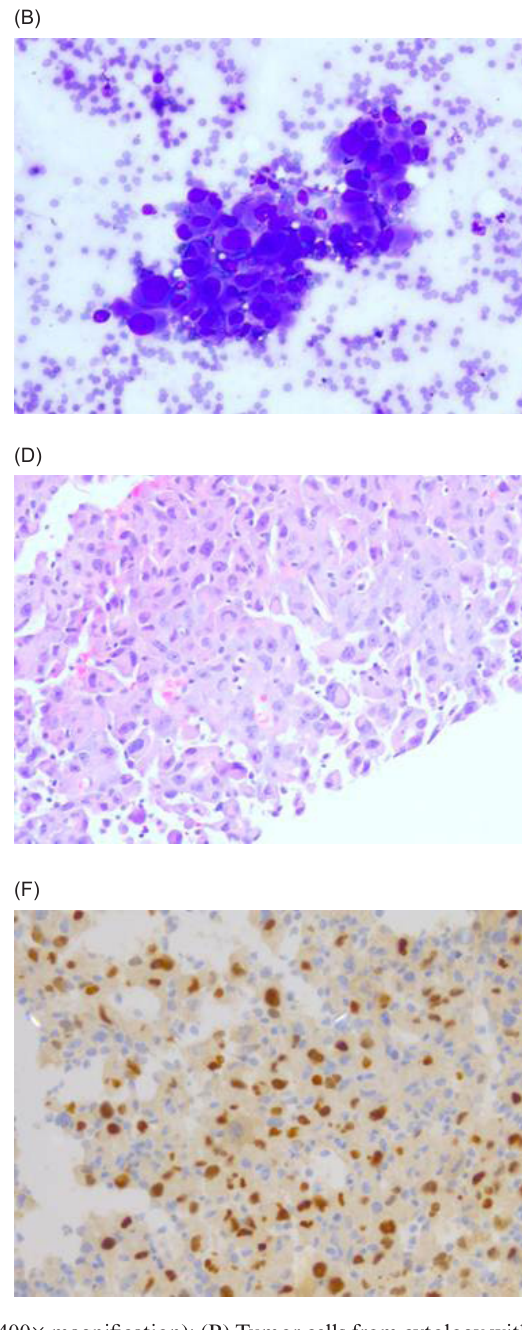
Figure 4: (A) Tumor cells from cytology with Papanicolaou stain (400× magnification); (B) Tumor cells from cytology with quick diff stain (400× magnification); (C–D) Tumor with featured rhabdoid cells (insert C) (C-200× magnification, insert 400× magni- fication; D-400× magnification); (E) Myogenin stain positive rhabdoid cells; (F) PAX 8 stain positive tumor cells. Surgical Pathology description: Cytology specimen shows groups of cells featured with large pleomorphic appearances of high nuclear-cytoplasm ratio, irregular nuclear membrane, and unevenly distributed chromatin. Core biopsy shows sheets of large pleomorphic cells with similar previously described features and abnormal mitosis. Scattered high-grade malignant cells with rhabdoid morphology are noted. The cells have large eccentric vesicular nuclei, prominent nucleoli, and abundant eosinophilic cytoplasm. Overall morphology is consistent with sarcomatoid-type renal cell carcinoma (RCC) with focal rhabdoid